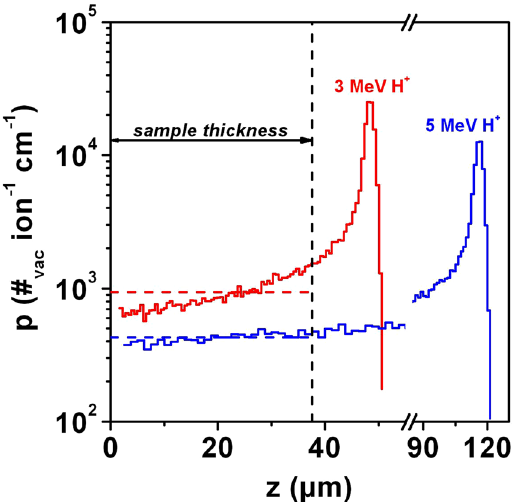
Figure 1. Ion damage profile. Depth profiles of linear vacancy concentration per single ion and unit length across the diamond sample thickness, as evaluated with SRIM SRIM-2008.04 Monte Carlo code for both 3 MeV (red plot) and 5 MeV (blue plot) proton irradiation. The vertical dashed line marks the thickness of the diamond sample, while the relevant average values across the sample thickness are reported by the horizontal dashed lines. Maximum and minimum values of the linear vacancy concentration across the sample thickness are: ~1.5 × 10 3 cm − 1 and ~7 × 10 2 cm − 1 for 3 MeV ions, ~4.7 × 10 2 cm − 1 and ~3.8 × 10 2 cm − 1 for 5 MeV